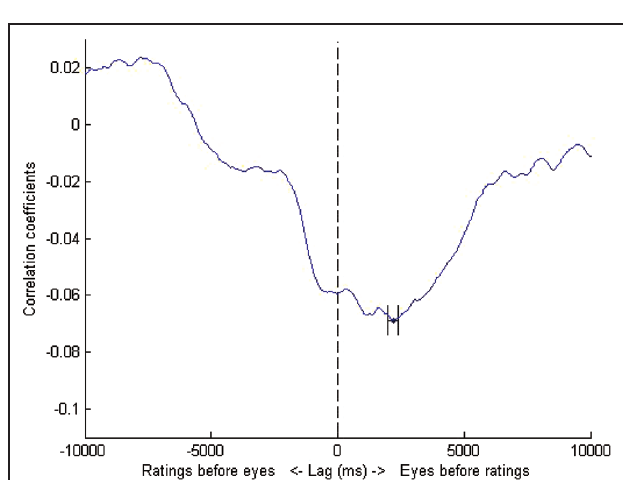
FIGURE 2 | DAF analysis for trained observers . The maximally negative correlation was obtained at a lag of 2180 ms i.e., the eyes led manual responses by a lag of just over two seconds. Error bars represent standard errors obtained by